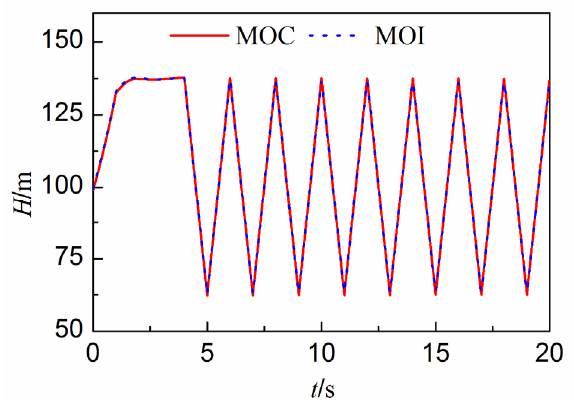
Figure 3. Pressure head traces at the valve for Case 1.